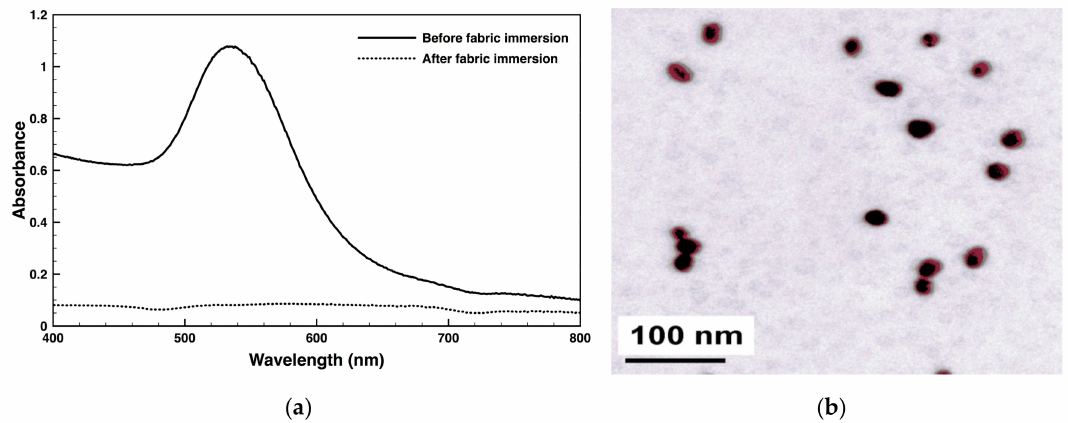
Figure 2. ( a ) Ultraviolet (UV)-visible spectra of Gold nanoparticles (AuNPs) colloidal suspension (400–800 nm). ( b ) Transmission electron microscopy (TEM) micrograph of the relatively monodispersed, highly spherical